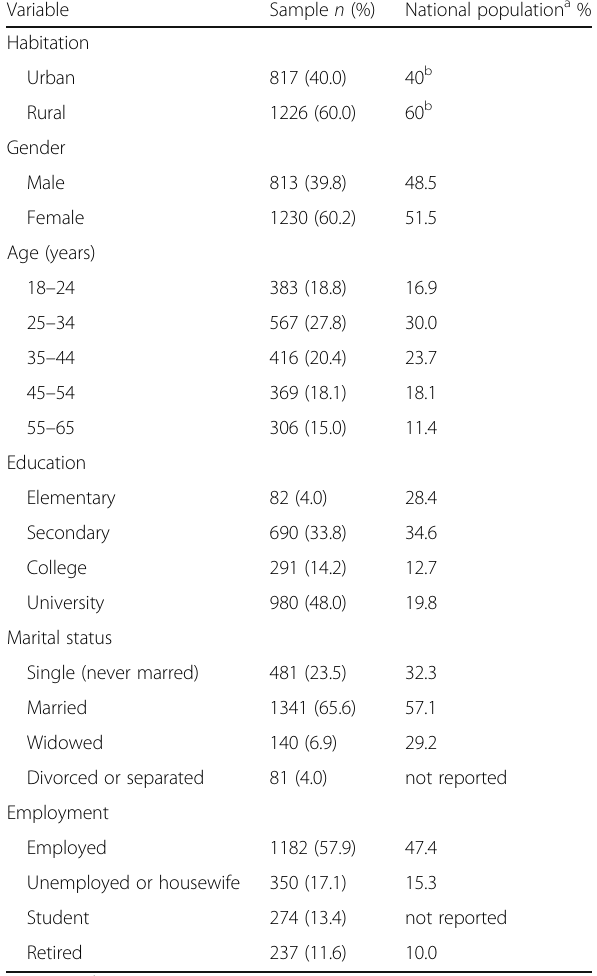
Table 1 Sociodemographic characteristics of the participating sample ( N = 2043) and national population